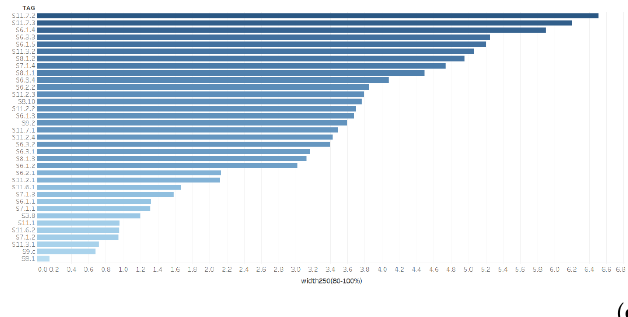
Figure 3. The order of indicators based on AWD at different index levels for three window widths (150, 200, 250). ( a ) Window width = 200, ( b ) Window width = 150, ( c ) Window width = 250. Across the five groups at different levels of the total index, Population Density (S11.3.1), Number of Beds in Social Welfare Institutions with Accommodation (S11.1),